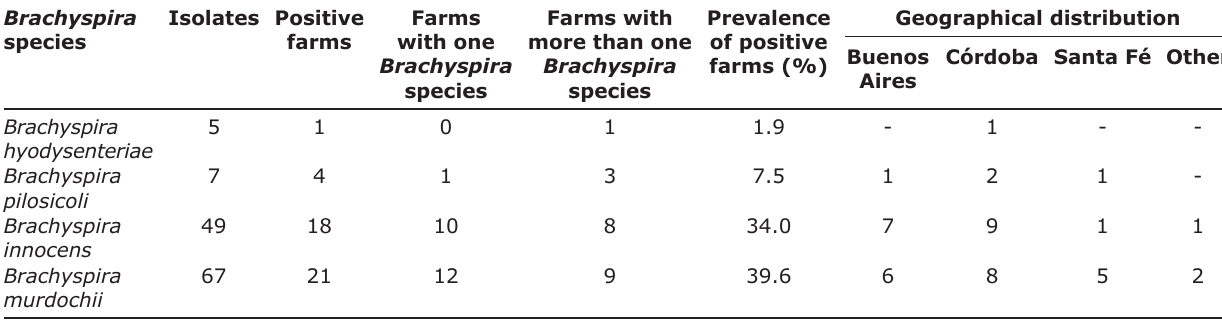
Table-2: Number of isolates of each identified Brachyspira species, number of positive farms, number of farms with only one or more than one Brachyspira species and regional prevalence of each identified Brachyspira species and distribution of the number of farms infected with each species in the different provinces. Brachyspira